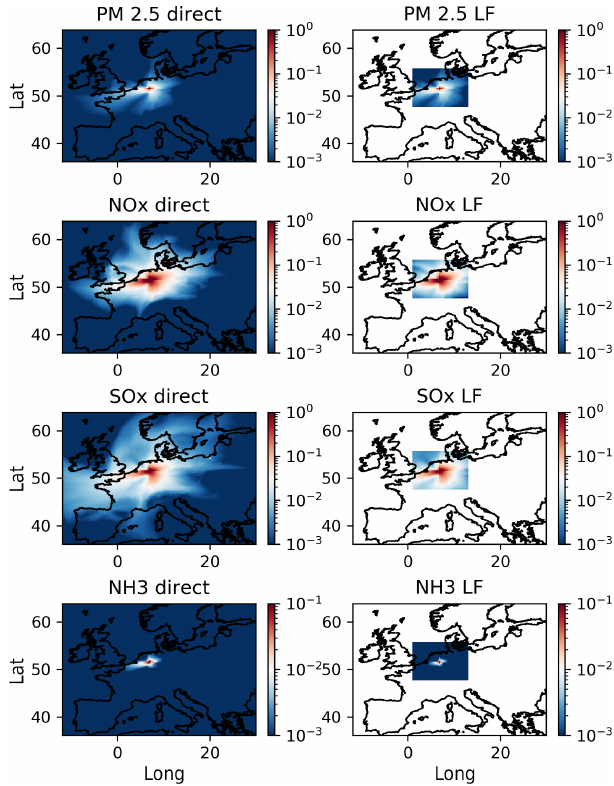
Figure 4. Receptor map for a single grid cell emission obtained through the direct method (left panels) and the local fraction method (right panels) averaged over 1 month (March 2016). Concentrations of PM 2 . 5 , NO x , SO x and NH 3 (in µgm − 3 ). The direct method re- quires a separate run for each source location. The local fraction method gives the receptor map in one single run in a limited region around the source but for any source grid